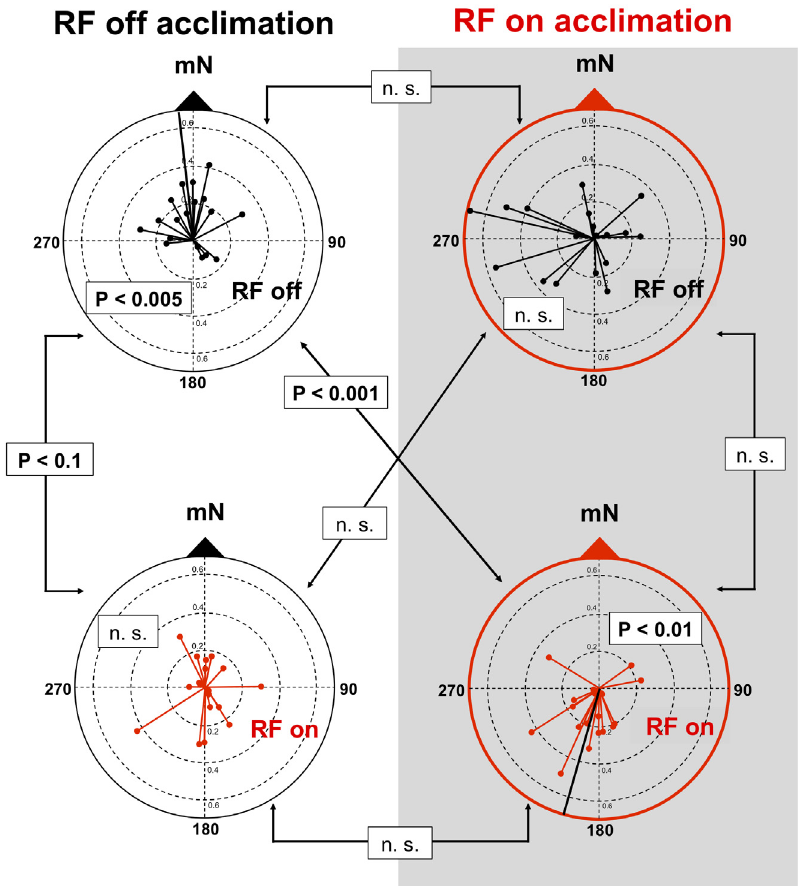
Fig 1. Magnetic component of responses of individual turtles plotted relative to magnetic North (mN). Magnetic directional preferences of turtles combined from four magnetic field alignments (magnetic north aligned in each of the four cardinal directions). Responses of turtles initially exposed to the magnetic field without RF are shown in the left column with black outer circles. Responses of turtles initially exposed to the magnetic field in the presence of the RF stimulus are shown in the right column with red outer circles. Black lines connected to black dots (labeled “ RF off ” ) are the mean vectors showing the magnetic component pooled from the four magnetic field alignments in which the turtles were tested without RF, and the responses shown in red (labeled “ RF on ” ) are from the four magnetic fields alignments in which the same turtles were tested in the presence of RF. Moore ’ s modified Rayleigh test was used to test each distribution for non- random unimodal alignment. Dependent data, e.g., diagrams in the left column or in the right column with the same colored circles (showing data collected from the same individuals), were tested for significant differences using Moore ’ s paired sample test. Independent data (i.e. distributions in the same horizontal row obtained from different individuals) were tested for significant differences using the Mardia ’ s two-sample